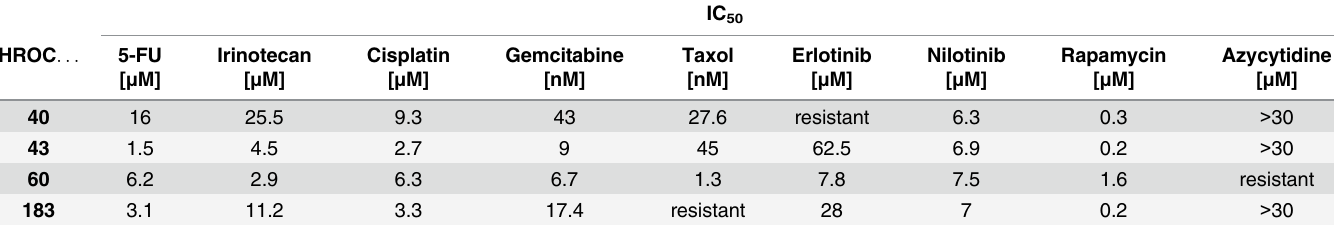
Table 4. Drug response of CIMP + cell lines.